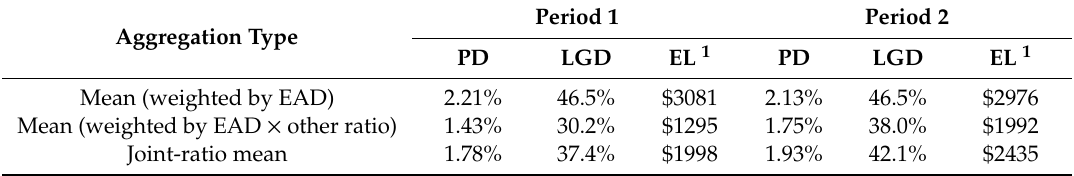
Table 3. Weighted Means of Table 1 exposures and their reconciliation to the actual